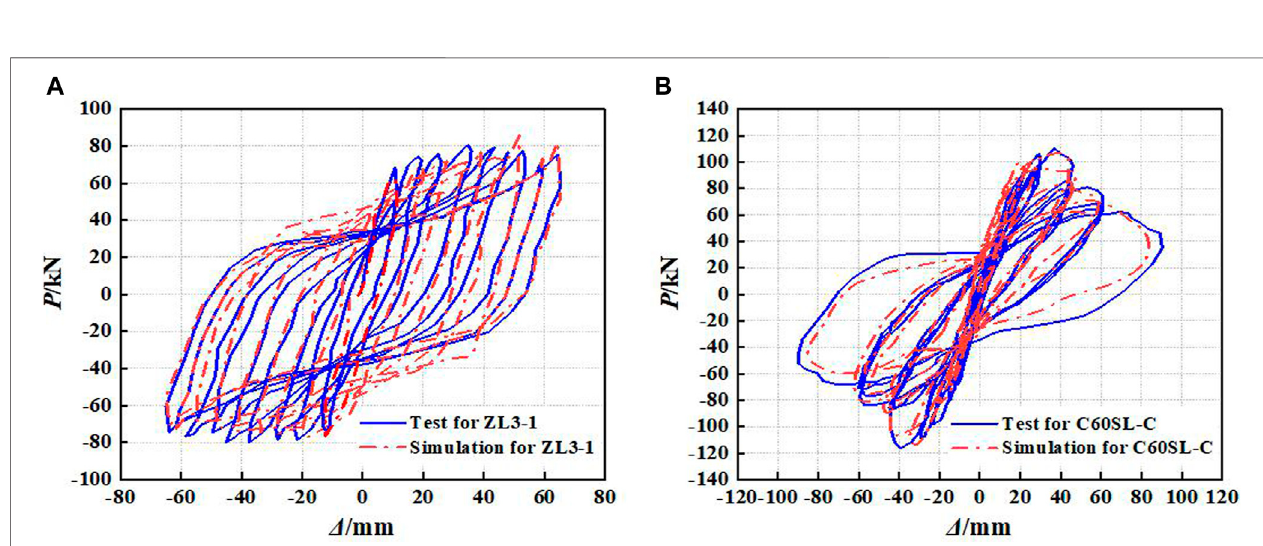
FIGURE 7 | Comparisons of hysteretic curves between test and simulation: (A) specimen ZL3-1; (B) specimen C60SL-C.